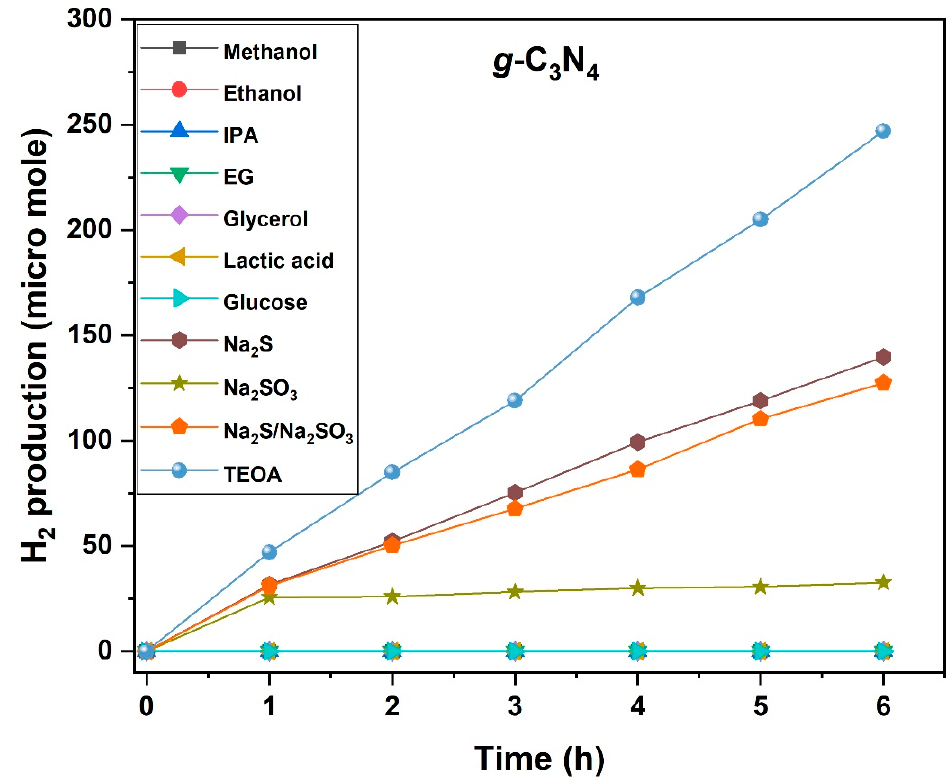
Figure 3. Photocatalytic H 2 production efficiency of g -C 3 N 4 using various sacrificial agents.